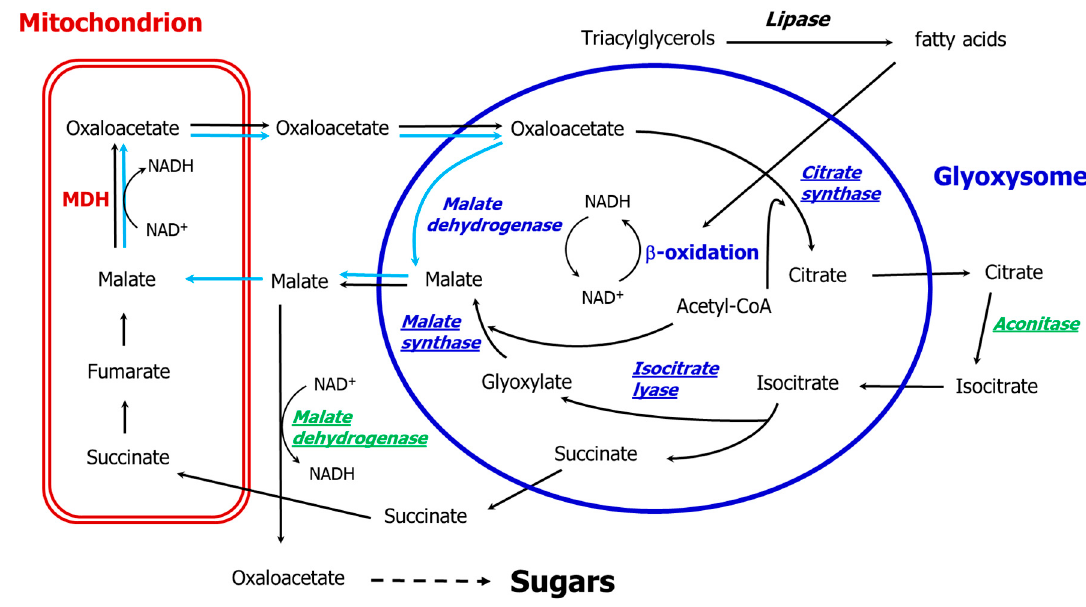
Figure 2. The path of carbon in the glyoxylate cycle after van Roermund et al. [46], Pracharoenwattana et al. [49] and Pracharoenwattana and Smith [5]. Black arrows indicate glyoxylate cycle reactions up to sugars, while light blue arrows indicate the malate/oxaloacetate shuttle transport/reactions; the cytosolic enzymes are given in green, the glyoxysomal enzymes in blue, and the enzymes of the glyoxylate cycle including the cytosolic malate dehydrogenase are underlined. MDH: mitochondrial malate